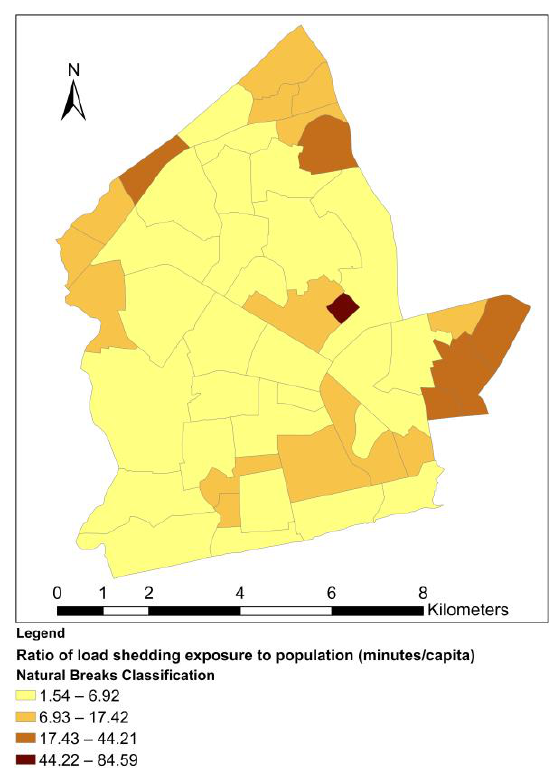
Figure 8. Neighborhood ratio of load shedding exposure to population.